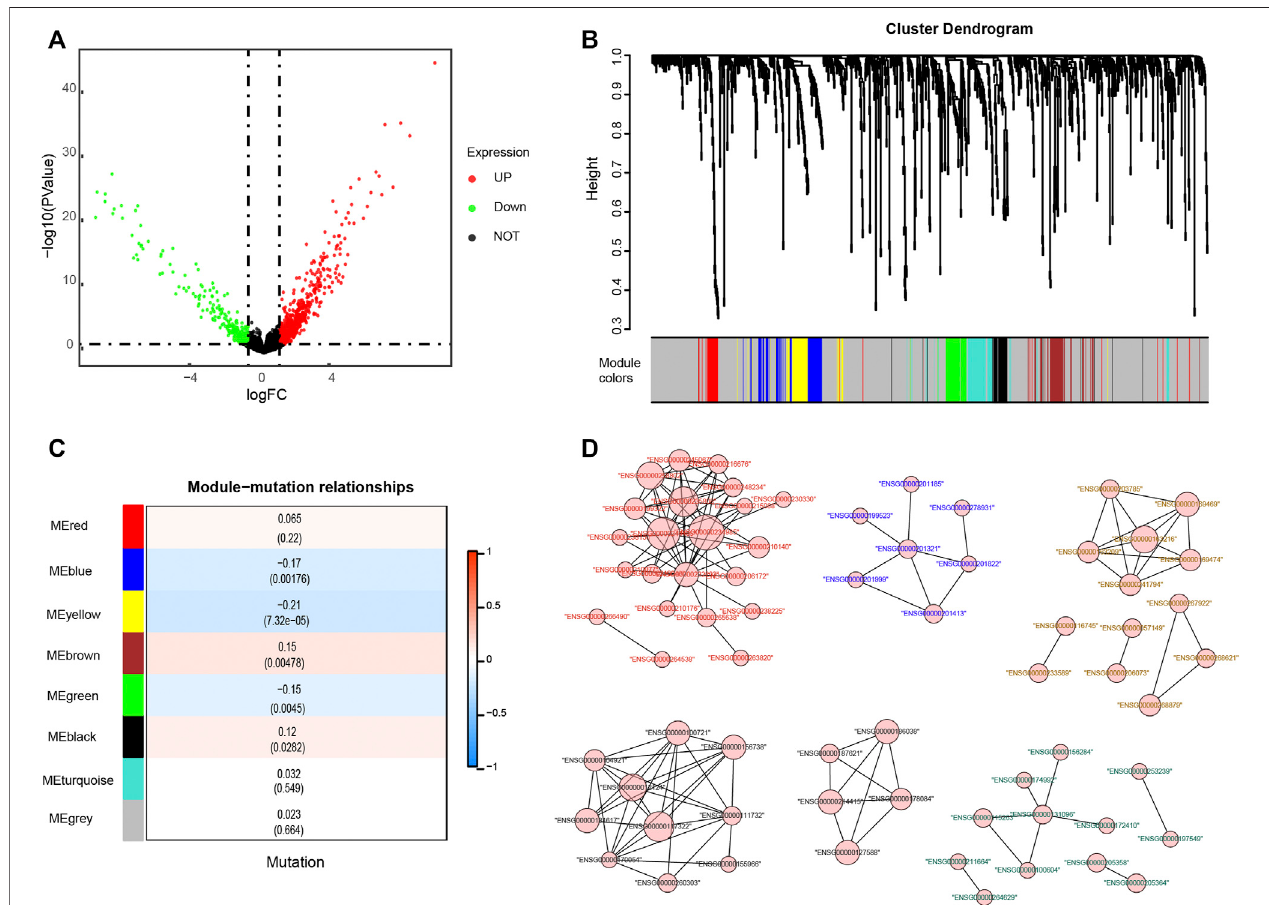
FIGURE2| Identi fi cationofgenesrelatedtoKRASmutations. (A) Differentiallyexpressedgenes(DEGs)ofKRASmutationsubgroupswithacut-offat p < 0.05and |log 2 FC| > 0.585 (B) Weighted gene coexpression network analysis (WGCNA) of KRAS mutation-related genes with a soft threshold β = 4 (C) Spearman correlation analysisofgenemodulesand KRASmutations. (D) ThegenenetworkofKRAS-related genes.Thecolorofthelabelsand theshape ofgenenodes indicate theaf fi liation of